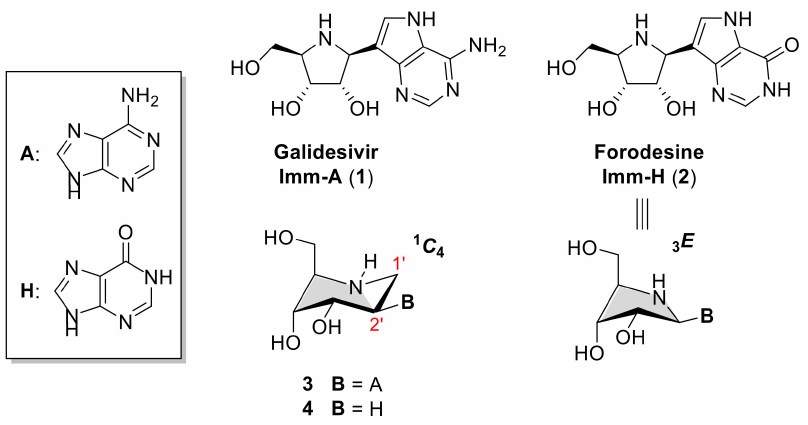
Figure 2. Immucillins A and H ( 1 and 2 ) and their conformationally restricted mimics 3 and 4